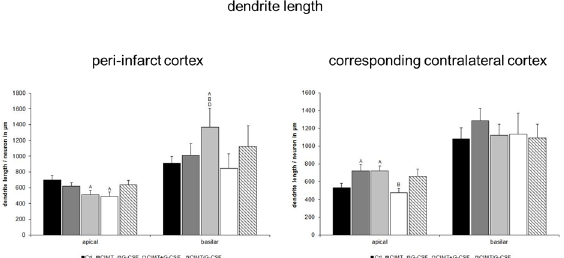
Fig 3. Dendritic length of Golgi Cox-impregnated layer V pyramidal neurons in the peri-infarct cortex and in the corresponding contralateral cortex. Quantitative analysis yielded a decrease in the mean length of the apical dendrites and an increase of the basilar dendrites in the peri-infarct cortex of the G-CSF group which was associated with significantly improved functional outcome in this group as recently shown [6]. However, the combined G-CSF and CIMT groups with a similar degree of functional recovery [6] lacked respective changes in the basilar dendritic length. In the corresponding contralateral cortex, a significant increase of the mean dendritic length of the apical dendrites of both G-CSF and CIMT treated rats without alterations of the basilar dendrites was seen (A, B, D, significant difference compared with control, CIMT, CIMT+G-CSF, respectively; values are expressed as length/neuron in μ m ± SEM; p <